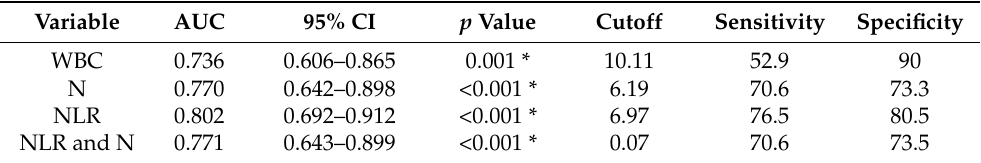
Table 3. Receiver operating characteristic curves of the variables as early predictor before propensity score-matched analysis.